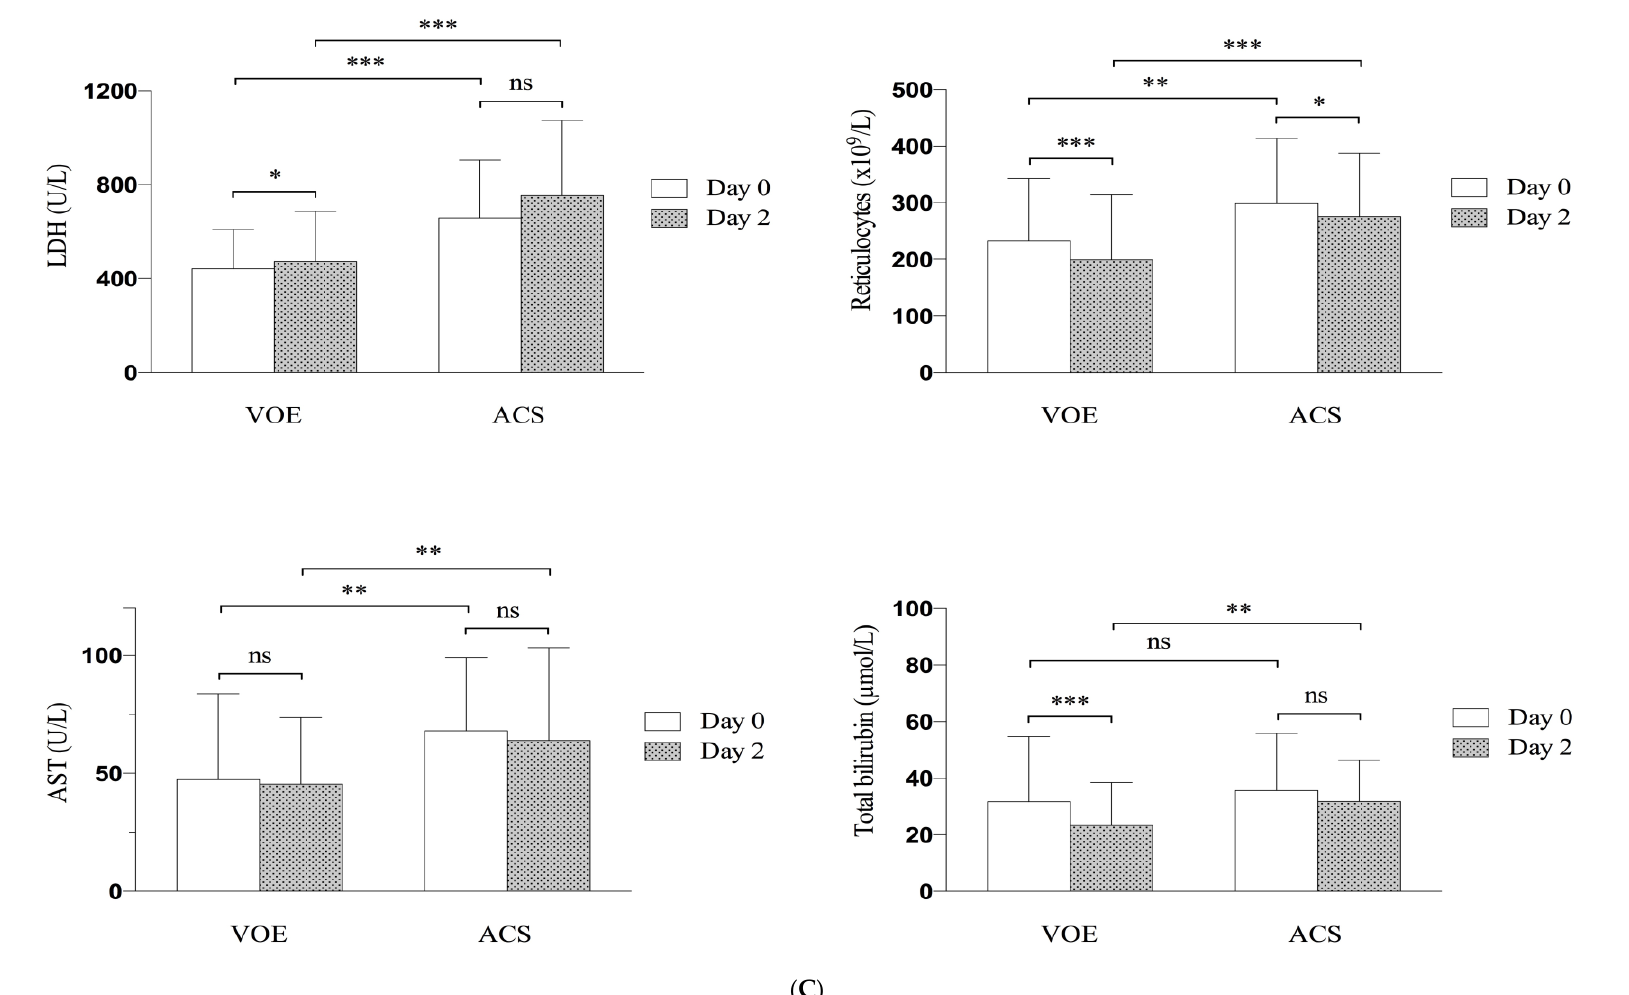
Figure 1. Dynamics of ( A ) clinical parameters ( B ) laboratory data in VOE versus ACS group and ( C ) hemolytic variables in VOE versus ACS group, by evolution of VOE in hospitalized children with sickle cell disease. VOE: vaso-occlusive episode; ACS: acute chest syndrome. * p < 0.05, ** p < 0.01, *** p < 0.001, ns: not significant. FPS, face pain score; SpO2, peripheral capillary oxygen saturation; CRP, C-reactive protein; LDH, lactate dehydrogenase; AST, aspartate aminotransferase.